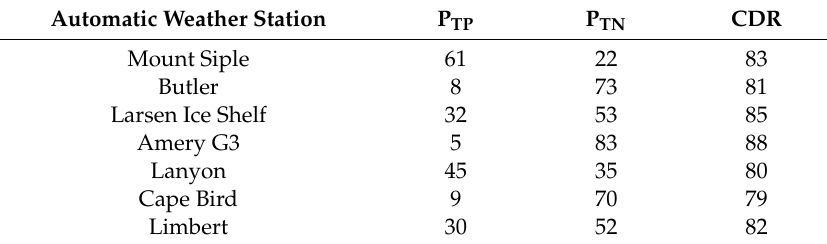
Table 3. Quantitative snowmelt detection results (in